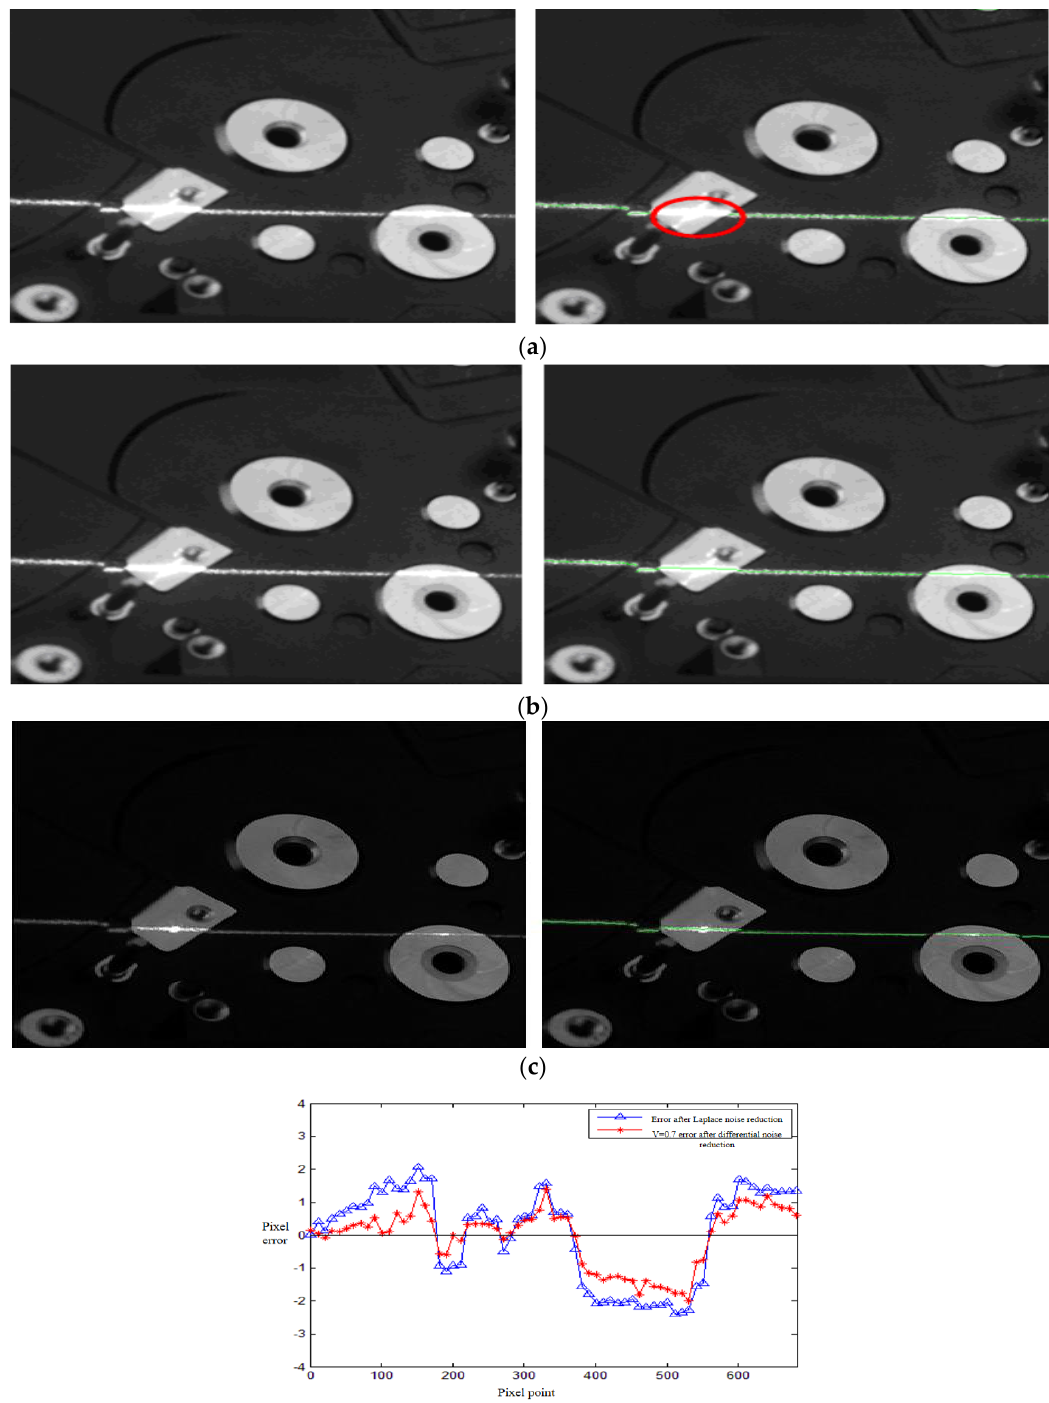
Figure 10. The extraction of the light stripe center of the hard disk substrate: ( a ) extracting the center of the light stripe after denoising using the Laplace method; ( b ) v = 0.7 extract of the center of the light stripe after differential denoising; ( c ) dark background dark light bar image extraction of the light bar center; ( d ) comparison of the center extraction performance between the Laplace method and the V = 0.7 fractional differential enhancement.